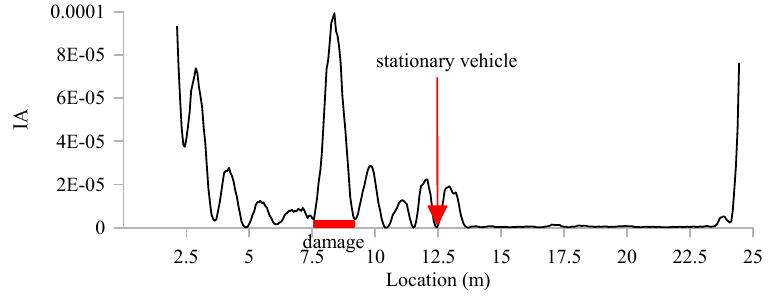
Figure 5. IA of the contact-point response of a stationary vehicle parked at mid-span.